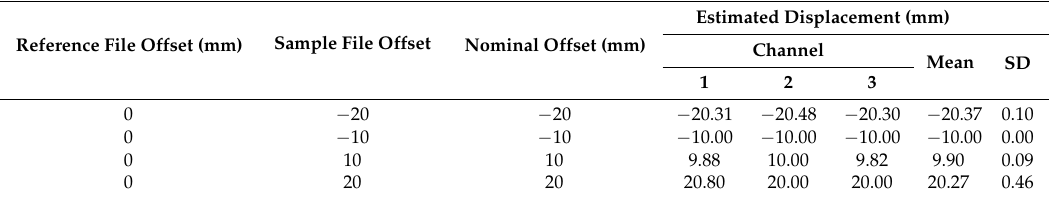
Table 5. Displacement estimates for outdoor test using an Orion Apex 102 mm Maksutov-Cassegrain Telescope with adjusted start